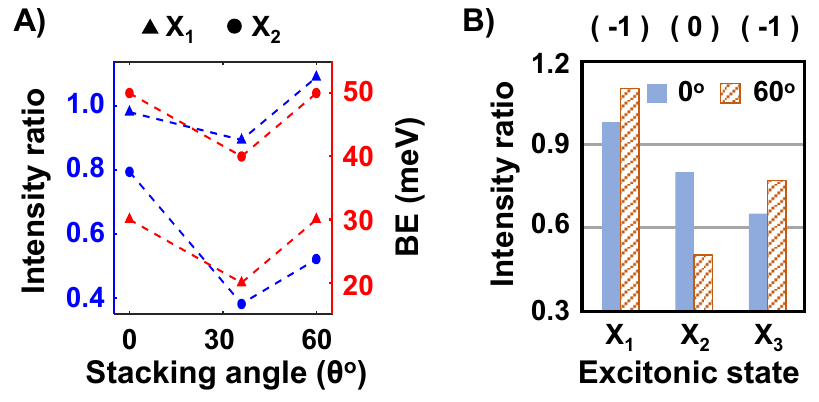
Figure 5: (A) Intensity ratio (the peak emission intensity normalized with respect to the intensity of neutral exciton) and the binding energies (BE) in meV of trion (X 1 ) marked as � and biexciton (X 2 ) marked as ● of BL-WSe 2 with different stacking angles at 100 K; and (B) Intensity ratio of trion (X 1 ), biexciton(X 2 ), andcharged-biexciton(X 3 ) of BL-WSe 2 stacked at 0 ° and 60 ° at 100 K. Top axis shows the charge of the species X 1 , X 2 , and X 3 as − 1, 0, or neutral and − 1